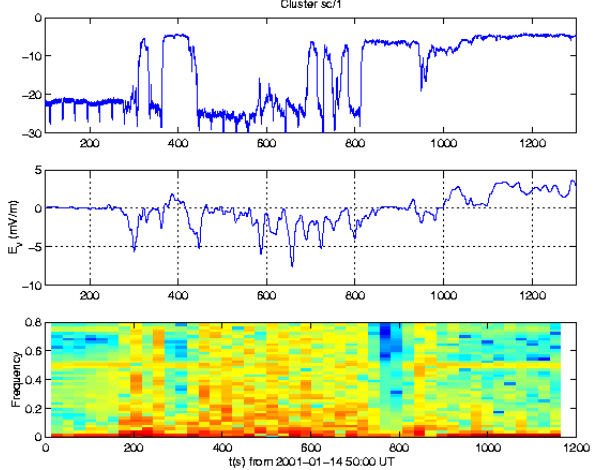
Figure 13. Fig. 13. For all four spacecraft, potential and the radial component of electric field, lowpass filtered at 0.06